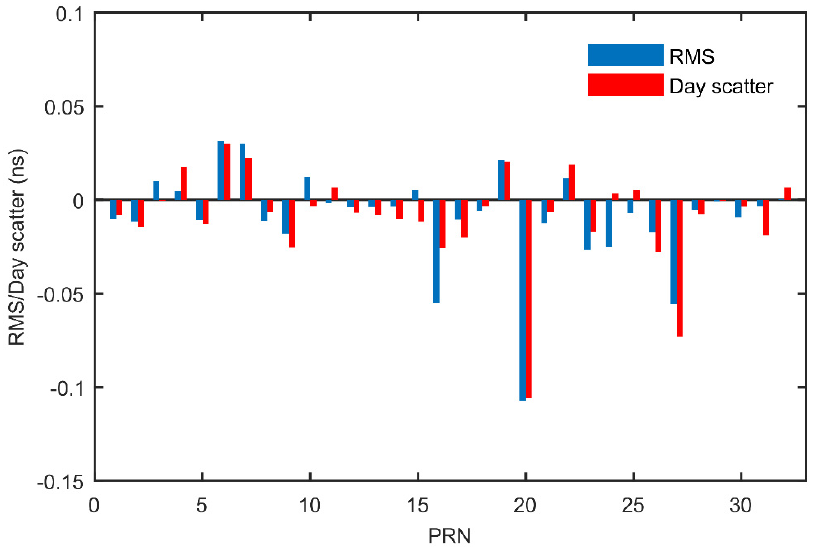
Figure 9. The difference of RMS and day scatter before and after selecting reference stations during the period of interests.